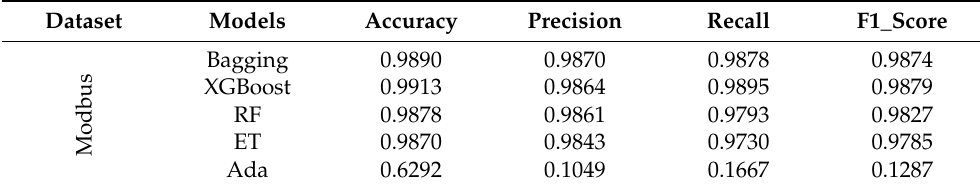
Table 7. The classification report for the Modbus